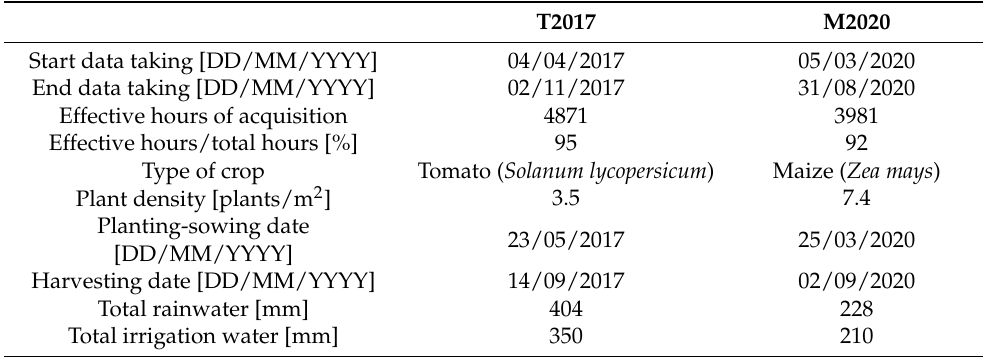
Table 2. Information of the T2017 and M2020 measurement campaigns, with the start and the end of the data taking, effective hours of acquisition, and effective hours/total hours ratios. The type of the crops and planting, sowing, and harvesting dates are reported together with plant density and the total precipitation and irrigation water